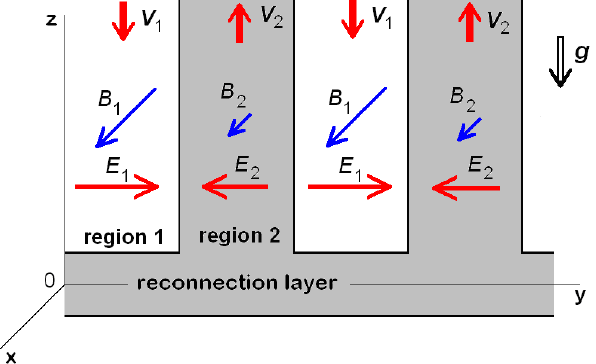
Figure 6. Schematic of resulting steady-state Rayleigh-Benard convection. Region 1 is related to Fig. 6. Schematic of resulting steady-state Rayleigh–B´enard con- plasma flows toward the reconnection layer while Region 2 to plasma flows out of this layer. vection. Region 1 is related to plasma flows toward the reconnec- tion layer, while region 2 is related to plasma flows out of this layer. Magnetic fields B and B are normal to the plane of the figure, g is an effective gravitational 1 2 Magnetic fields B 1 and B 2 are normal to the plane of the figure, g acceleration, E and E are the polarization electric fields, and V 1 2 is an effective gravitational acceleration, E 1 and E 2 are the polar- velocities in the regions 1 and 2, respectively. The convection is shown only in the region above ization electric fields, and V 1 and V 2 are the E × B drift velocities in the regions 1 and 2, respectively. The convection is shown only directions (not shown). in the region above the reconnection layer; below the reconnection layer, the magnetic fields have the opposite directions (not